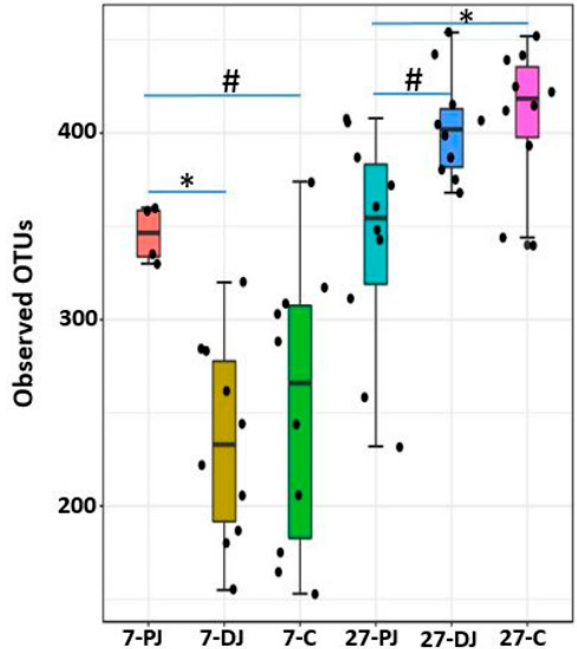
Figure 9. Alpha diversity between two different locations at two different post-weaning ages as measured by Observed_OTUS metric. ** represents significant difference between two groups at p < 0.001. The 7 and 27 represent 7 and 27 days, respectively, after weaning; M and D represent mucosa and digesta samples, respectively.